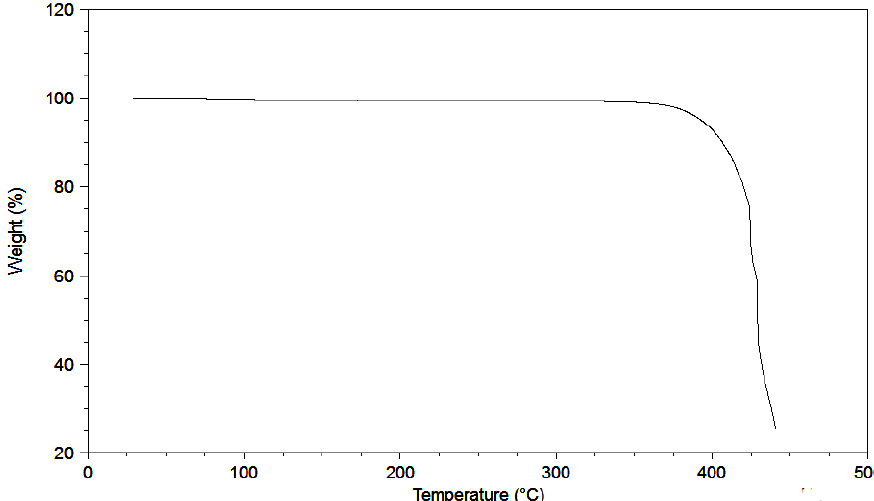
Figure 1. TGA of N -butyl- N -methylpyrrolidinium trifluoromethanesulfonate. Scan rate: 10 °C/min.